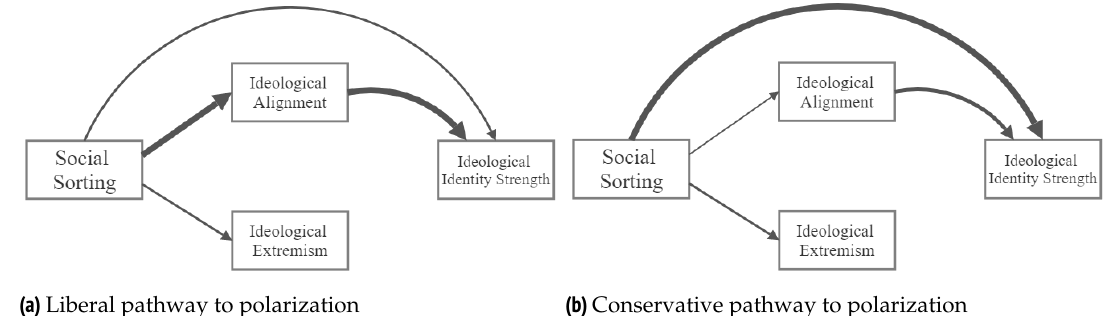
Figure 4: Two predominant pathways leading from social sorting to ideological identity strength based on significant coefficients in reported